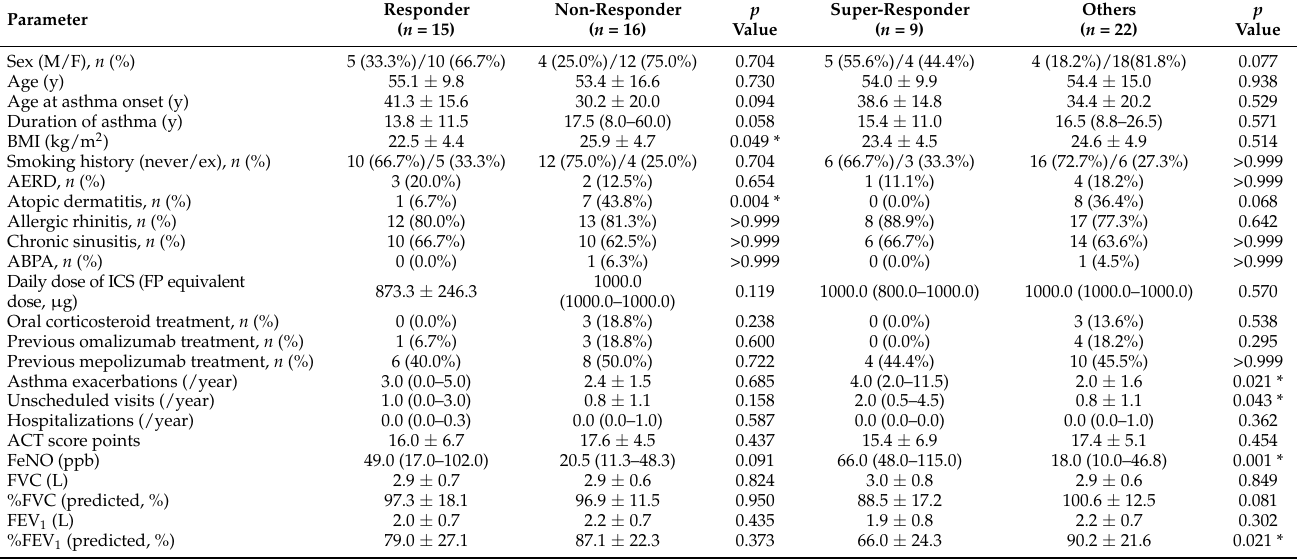
Table 4. Responder analysis of benralizumab